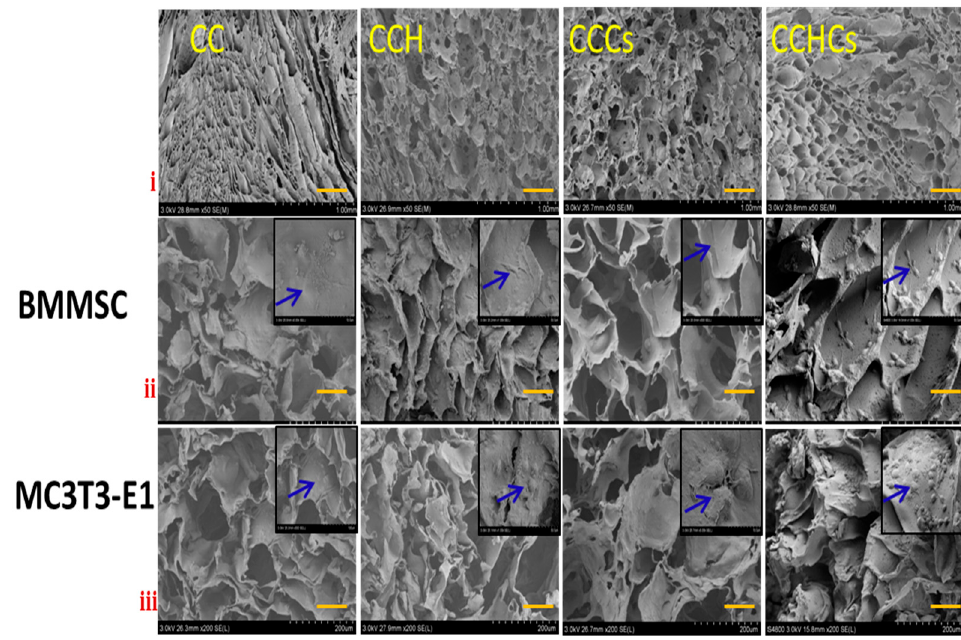
Figure 8. Scanning electron microscope (scale bars: i = 1.0 mm, ii and iii = 200 µm) images of bone cells cultured on 3D matrices for 14 days. The small inset in the SEM image is showing the expanded magnification at 50 µm. CC: chitosan-collagen 3D matrix, CCH: chitosan-collagen-hydroxyapatite 3D matrix, CCCs: chitosan-collagen-chondroitin sulfate 3D matrix, and CCHCs: chitosan-collagen-hydroxyapatite-chondroitin sulfate 3D matrix.